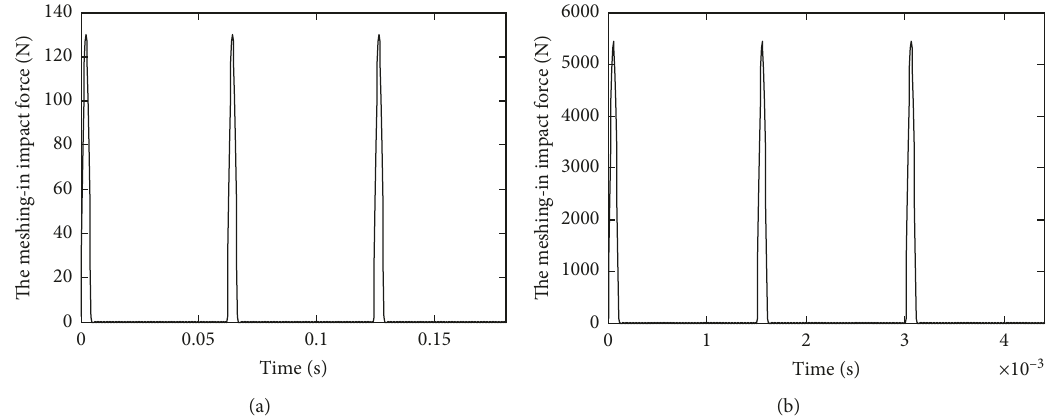
Figure 10: Meshing-in impact force at (a) low speed (50.8 rpm) and (b) high speed (2104rpm).